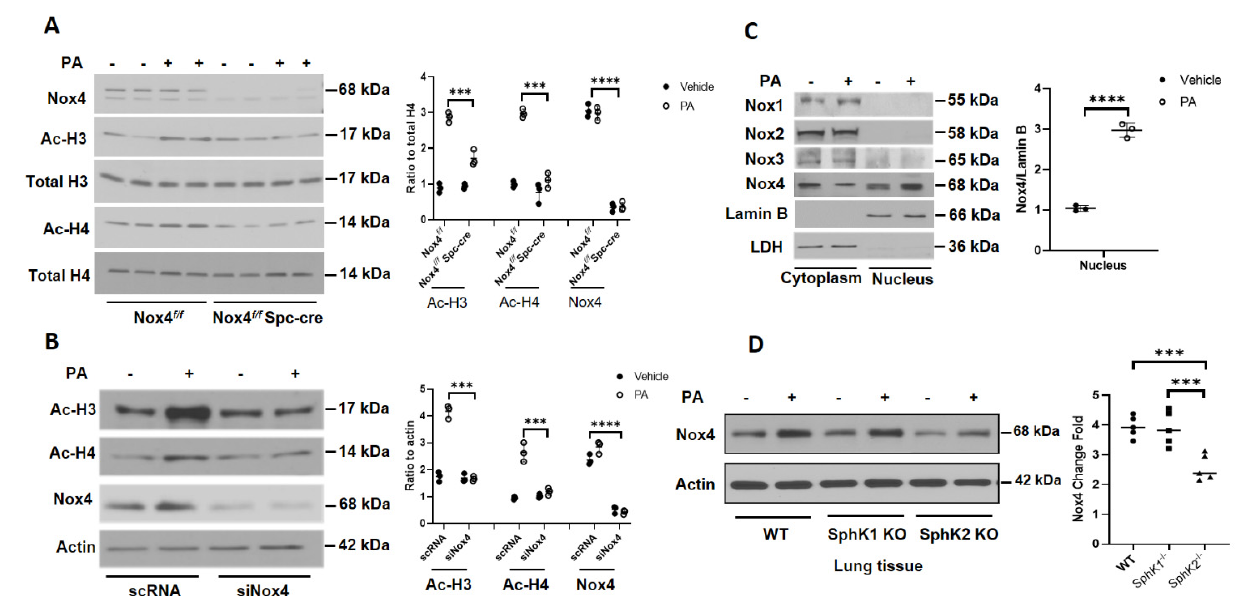
Figure 3. Deletion of Nox4 reduces P. aeruginosa- induced histone acetylation in primary alveolar type II cells isolated from Nox4 flox/flox and LEp-Nox4 knock out ( KO ) mice. ( A ) Primary alveolar type II cells were isolated from Nox4 flox/flox and LEp-Nox4 KO mice and challenged with heat-inactivated P. aeruginosa ( PA ) (1 × 10 8 CFU/mL) for 3 h, as described under Experimental Procedures. Cell lysates were subjected to SDS-PAGE and Western blotting and probed for NADPH Oxidase 4 (NOX4), acetylation of histone proteins H3 and H4, with specific antibodies to H3K9, H4K8, and total H3 and H4 histone antibodies. Shown is a representative blot and values are means ± SD from three independent experiments. *** p < 0.005, **** p < 0.001 between PA groups. ( B ) Primary human bronchial epithelial cells (HBEpCs) were transfected with scRNA or Nox4 siRNA (50 nM) for 48 h before heat-inactivated PA (1 × 10 8 CFU/mL) challenge for 3 h. Acetylation of histone proteins H3 and H4 and knockdown of Nox4 were evaluated by Western blotting. Shown is a representative blot and values are means ± SD of three independent experiments. *** p < 0.005, **** p < 0.001 between PA groups. ( C ) Primary HBEpCs were treated with vehicle or heat-inactivated PA (1 × 10 8 CFU/mL) for 3 h and then trypsinized. Cytoplasm and nuclear fractions were isolated by sucrose density gradient centrifugation as described in Experimental Procedures. Expression of NOX1-4 proteins was detected by Western blotting. Lamin B and LDH were used as markers for nucleus and cytoplasm, respectively. **** p < 0.001 compared with vehicle. ( D ) Wild type, Sphk1 − / − , and Sphk2 − / − mice (number of mice per group = 5) were challenged intratracheally with sterile PBS or PA (1 × 10 6 CFU/mouse) for 24 h. Lung tissue lysates (30 μ g protein) were subjected to SDS-PAGE and Western blotting for NOX4 and actin using specific antibodies. Shown is a representative blot and values are means ± SD from three independent experiments. *** p < 0.005.